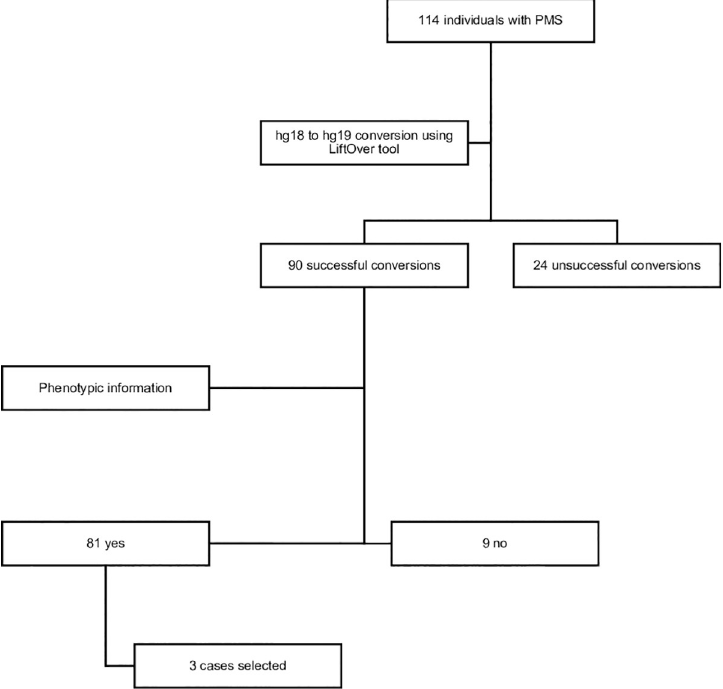
Fig 1. Flowchart for the selection of individuals with PMS. The initial cohort consisted of 114 patients; after applying a series of conditions mentioned above, 3 individuals were selected for this study. Two unrelated individuals were included in the study, reaching a total of 5 individuals.